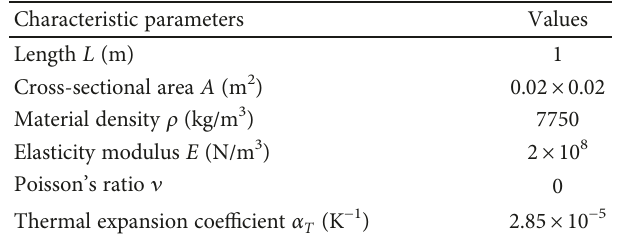
Table 1: Material properties and geometry sizes of the pendulum.